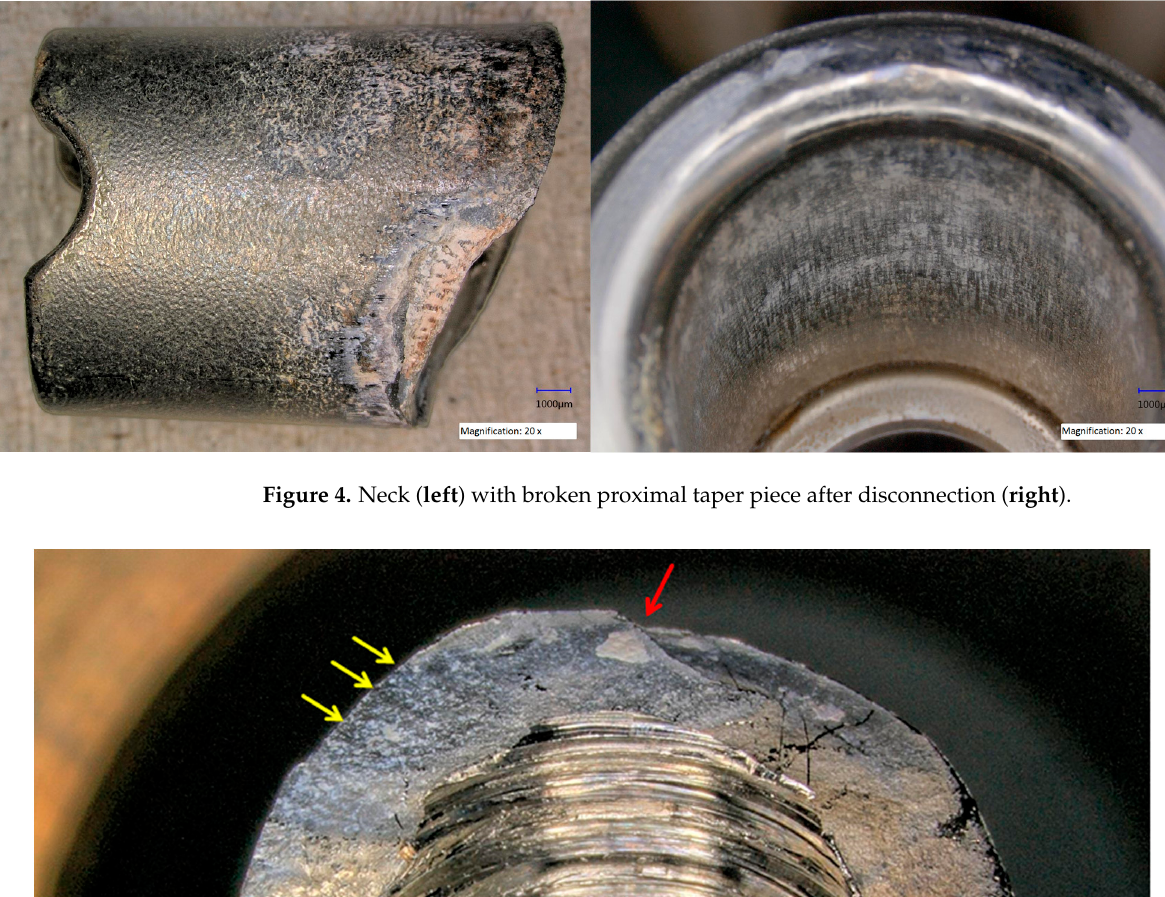
Figure 3. Neck piece ( left ) and lateral view of the broken taper ( right ).